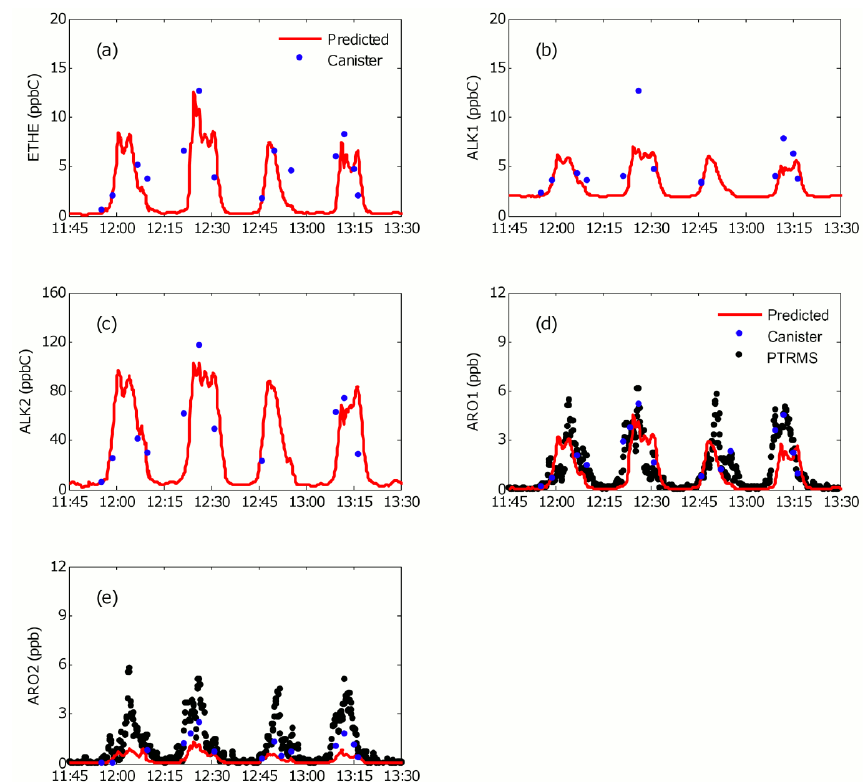
Fig. 8. Time series for VOCs on 27 March are shown. Canister measurements were collected within 1–2 min (blue dots), and real-time VOCs analyzed by PTRMS were taken at 10-s intervals (black dots). Simulations were temporally and spatially interpolated to correspond to each measurement. 5 Table 3. Percentage changes of episode averaged peak ozone concentrations due to emission reductions under different meteorological